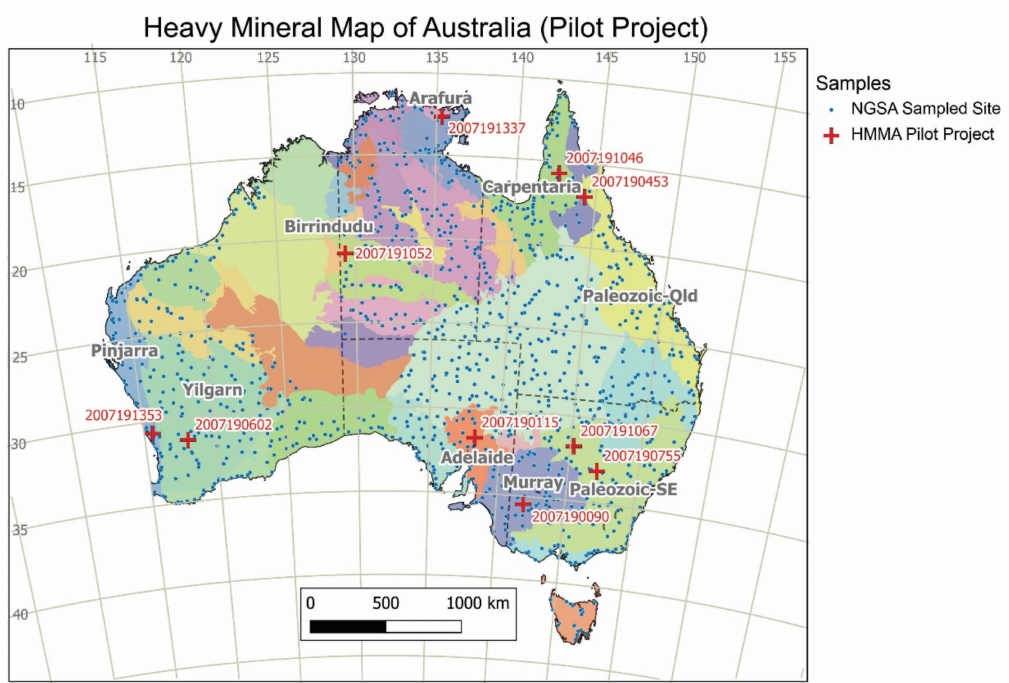
Figure 1. Distribution of National Geochemical Survey of Australia (NGSA) sample sites (blue dots), including the 10 pilot project sites discussed herein and identified by sample ID (red plusses), overlain on Australia’s geological regions (variable colors; [34]). Relevant geological regions are labelled. Map projection: Albers equal